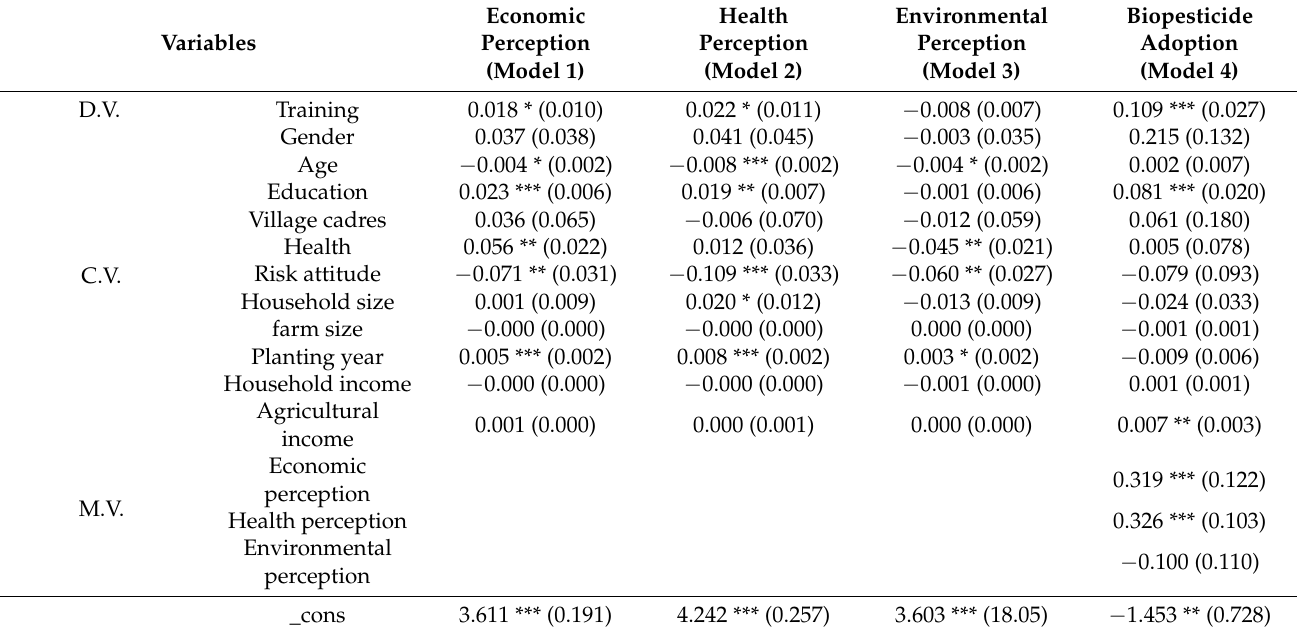
Table 4. The results of the mediating effects of farmers’ technology